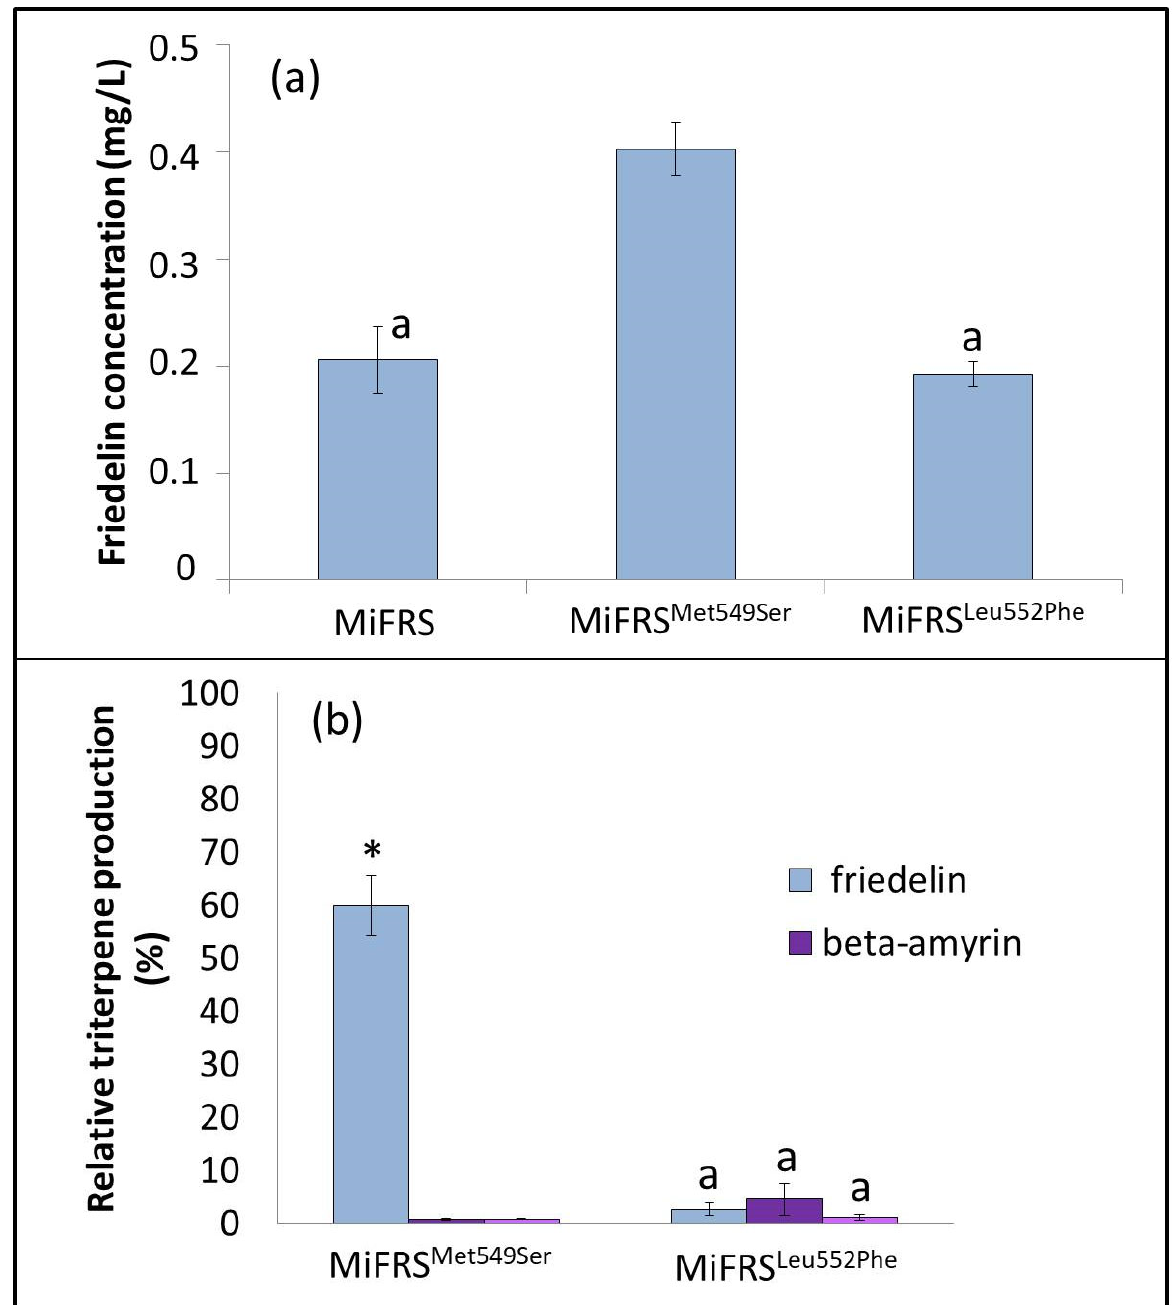
Figure 7. Concentration of friedelin in fractions extracted from S. cerevisiae yeast, expressing Mi FRS mutants. ( a ) Concentration of friedelin is expressed in mg/L of culture medium. (Complementary Data in Supplementary Material, Table S4). ( b ) Proportion between friedelin, β‐ amyrin and α‐ amyrin produced in the mutants of Mi FRS. A statistically significant difference is indicated by one asterisk (*) on the top of the bar, after analysis of variance. Bars with the same letter denote an absence of a statistically significant difference between each other on the quantification friedelin in the respective season ( p > 0.05; one ‐ way ANOVA with Tukey’s test).